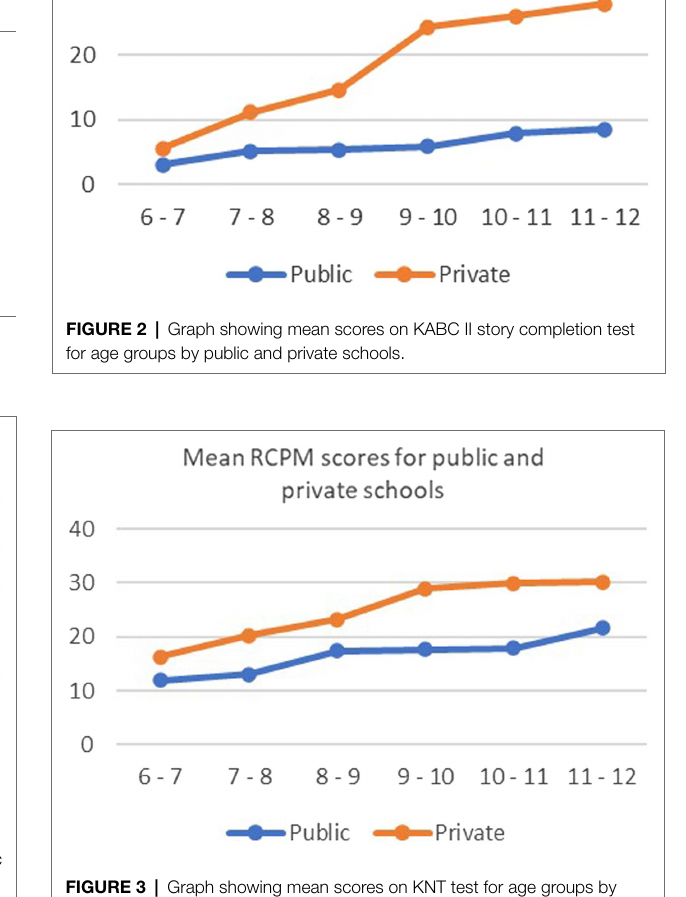
FIGURE 3 | Graph showing mean scores on KNT test for age groups by public and private schools.